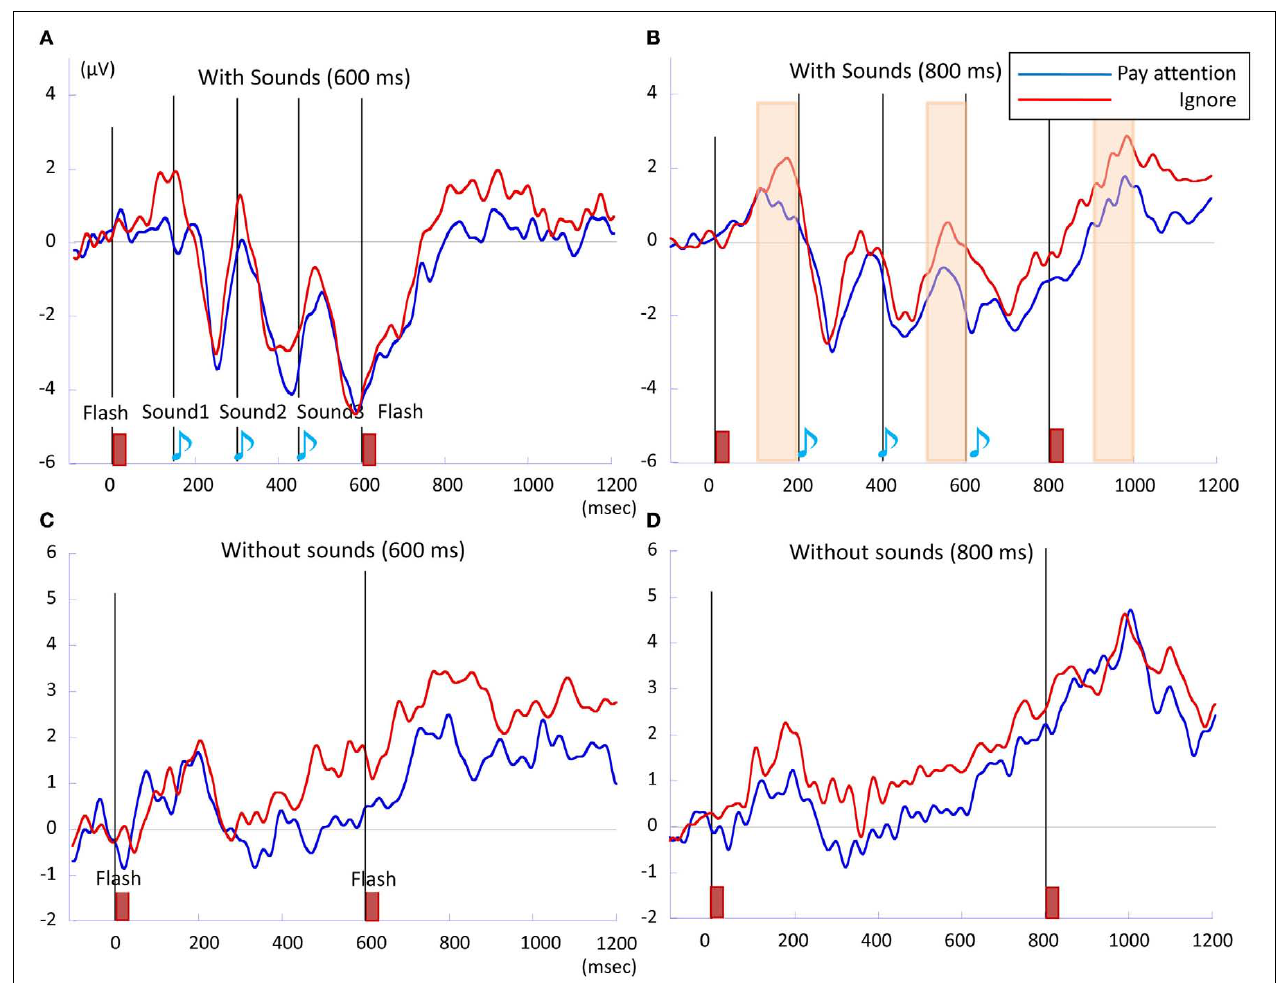
(FP1, FP2, F3, F4, Fpz, and Fz). Pay attention condition is in blue, while Ignore condition is in red. Pale orange bars represent the temporal windows where the integrated amplitude in Pay attention condition is larger than in Ignore condition. Each is corresponding to the tw2, tw6, and tw10,